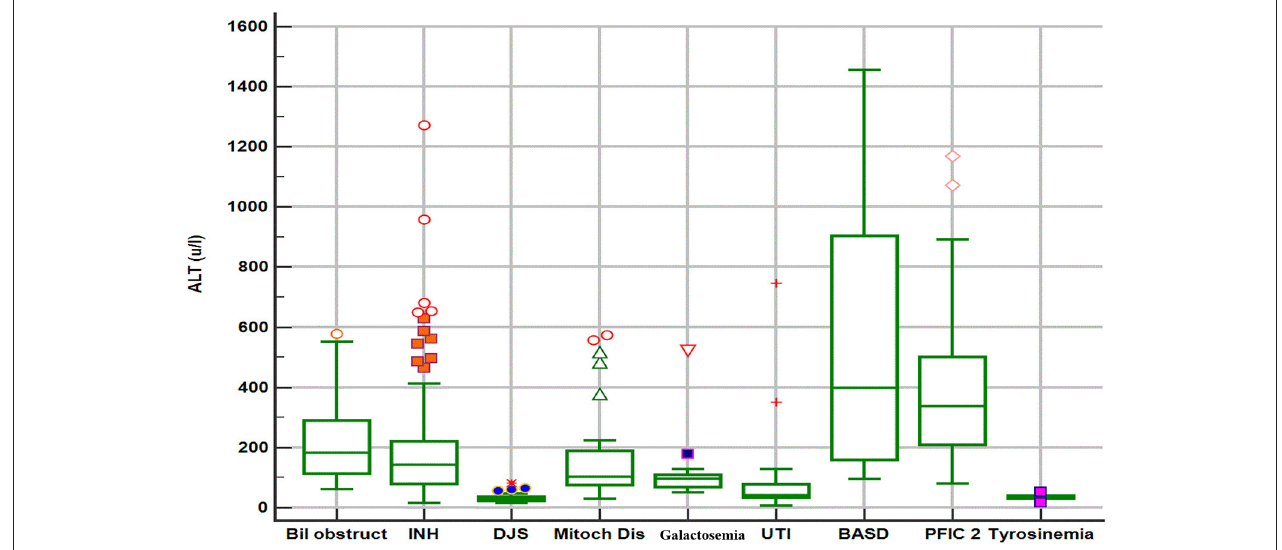
FIGURE 1 | Box plot graph of alanine aminotransferase values in different etiologies of neonatal cholestasis. Bil obstruct, biliary obstruction (biliary atresia and choledochal cyst); DJS, Dubin–Johnson syndrome; INH, idiopathic neonatal hepatitis; Mitoch Dis, mitochondrial disorders; PFIC2, progressive familial intrahepatic cholestasis type 2; BASD, bile acid synthetic disorders; UTI, urinary tract